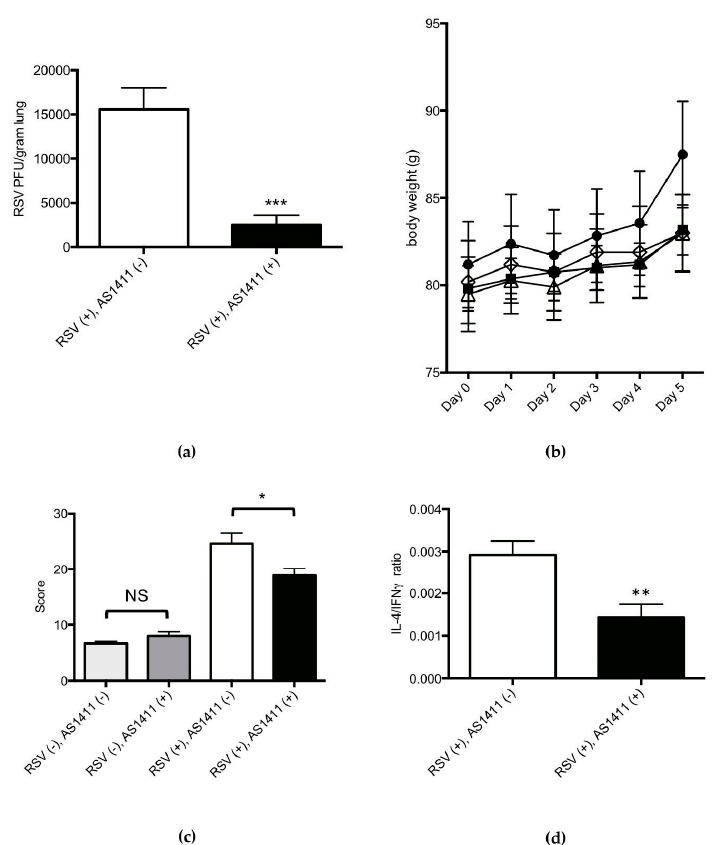
Figure 5. In Vivo cotton rat data demonstrating the efficacy of AS1411 in reducing viral infection. ( a )